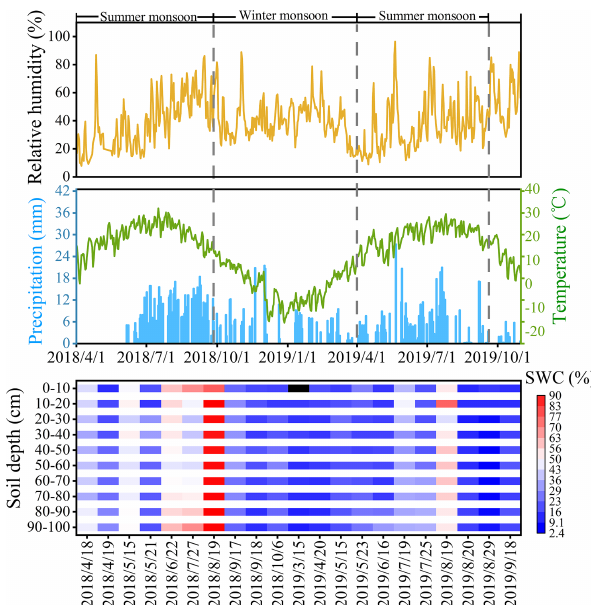
Figure 2. Diurnal variation in relative humidity, precipitation, tem- perature, and swc (%) from April 2018 to October 2019. The date is given in the format